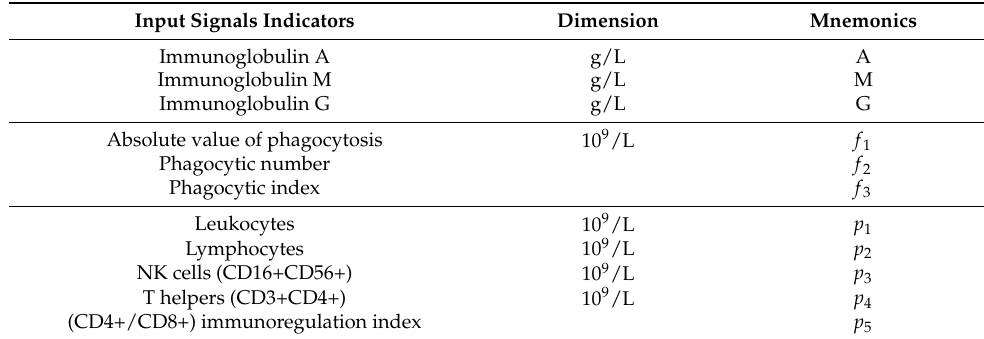
Table 1. Coding of immunogram indicators. Input Signals